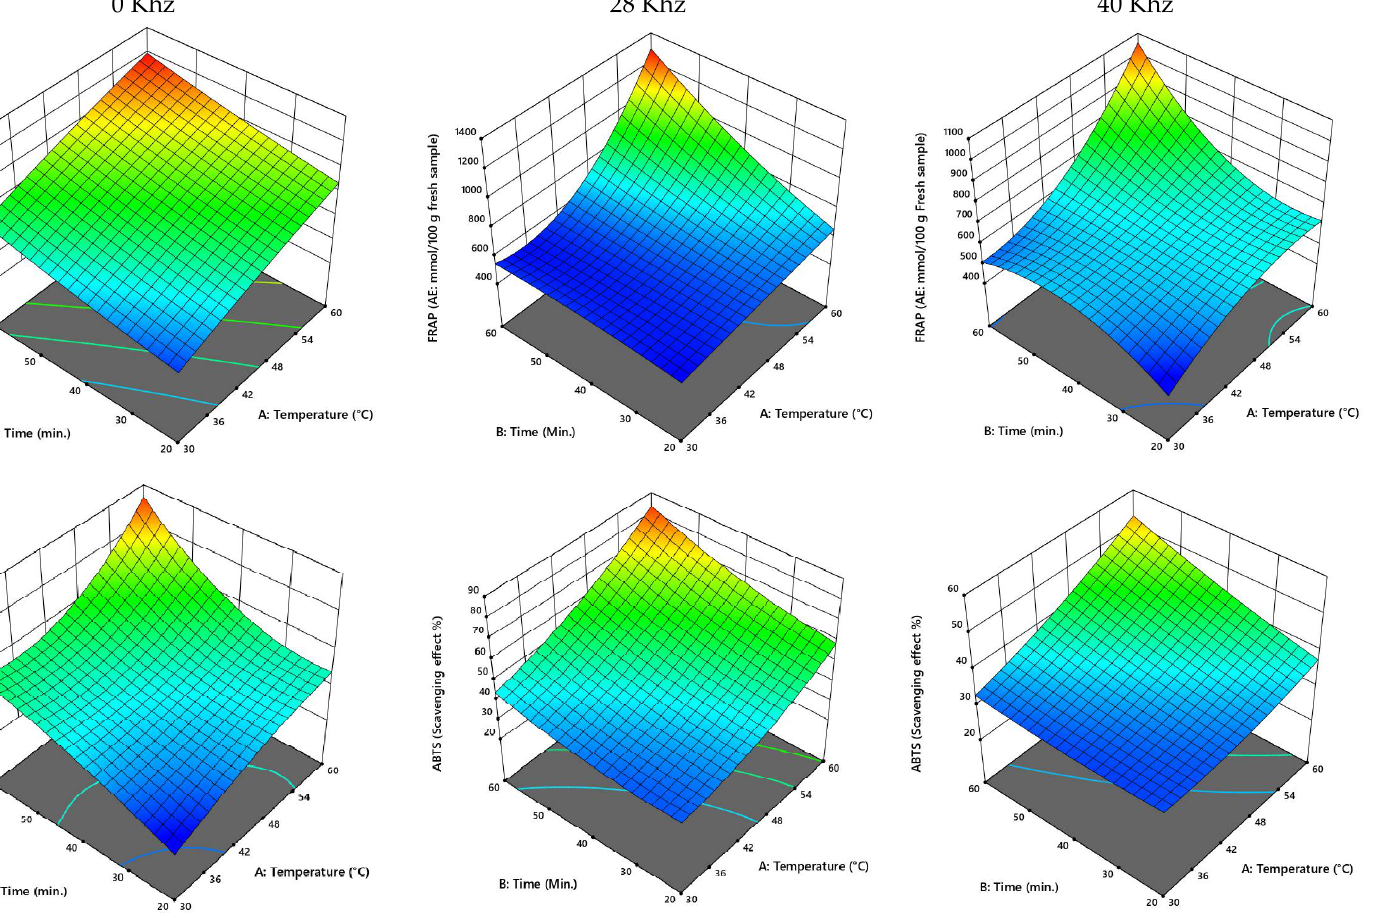
Figure 1. 3D response surface plot for response variables (TPC, TFC, FRAP, and ABTS) as a function of UAE with frequency 0, 28, and 40 kHz in Agwa date palm fruits’ cultivar.